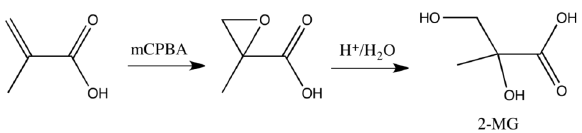
Fig. 2. Synthesis of 2-MG from methacrylic acid.2